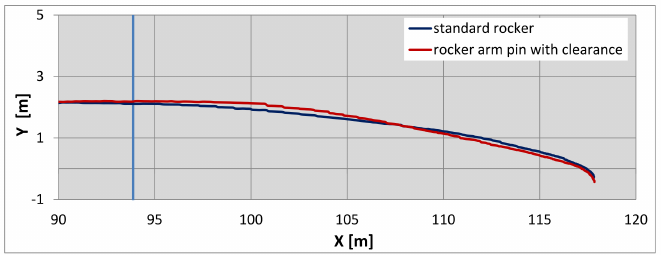
Figure 12. Change of the trajectory caused by resetting the rocker arm clearance during braking (blue line—braking